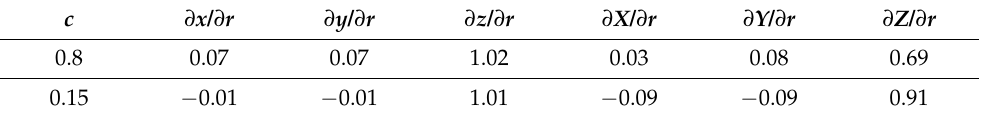
Figure 2. Original (red) and pseudo (blue) trajectories for the fast z and slow Z variables, calculated for strong coupling between fast and slow systems ( c = 0.8). Table 1. Sensitivity functions for fast and slow variables for strong ( c = 0.8) and weak ( c = 0.15 ) coupling between systems.